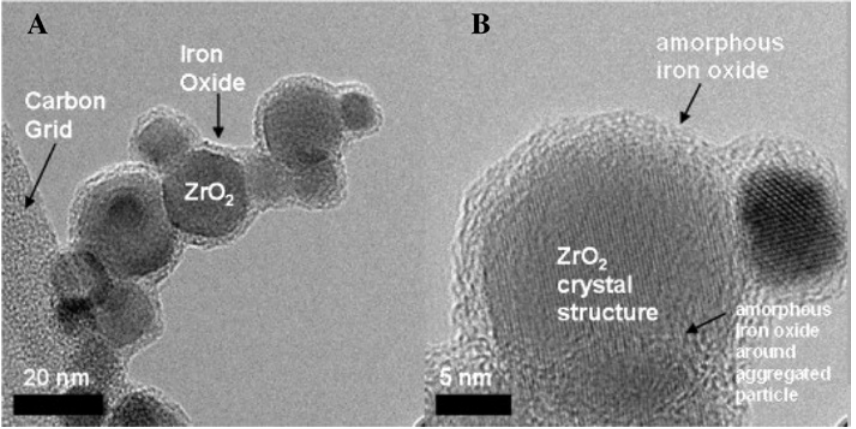
Figure 14: HRTEM micrographs of iron oxide layers on zirconia nanoparticles. Reprinted with permission from Ref. [114]. Copyright 2008 Elsevier